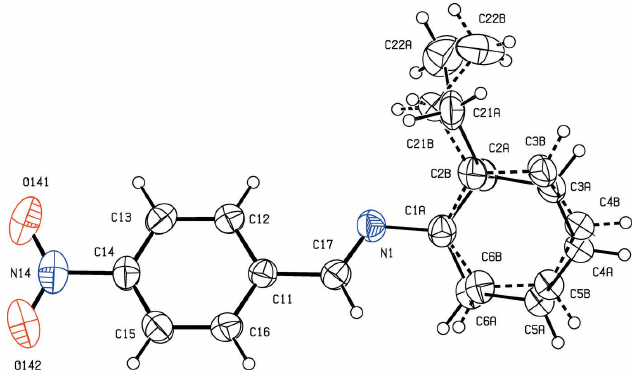
Figure 1 The molecular structure of compound (I) showing the atom-labelling scheme. Displacement ellipsoids are drawn at the 30% probability level, and for the disordered 2-ethylphenyl group, the major component is drawn using solid lines and the minor component is drawn using dashed lines.